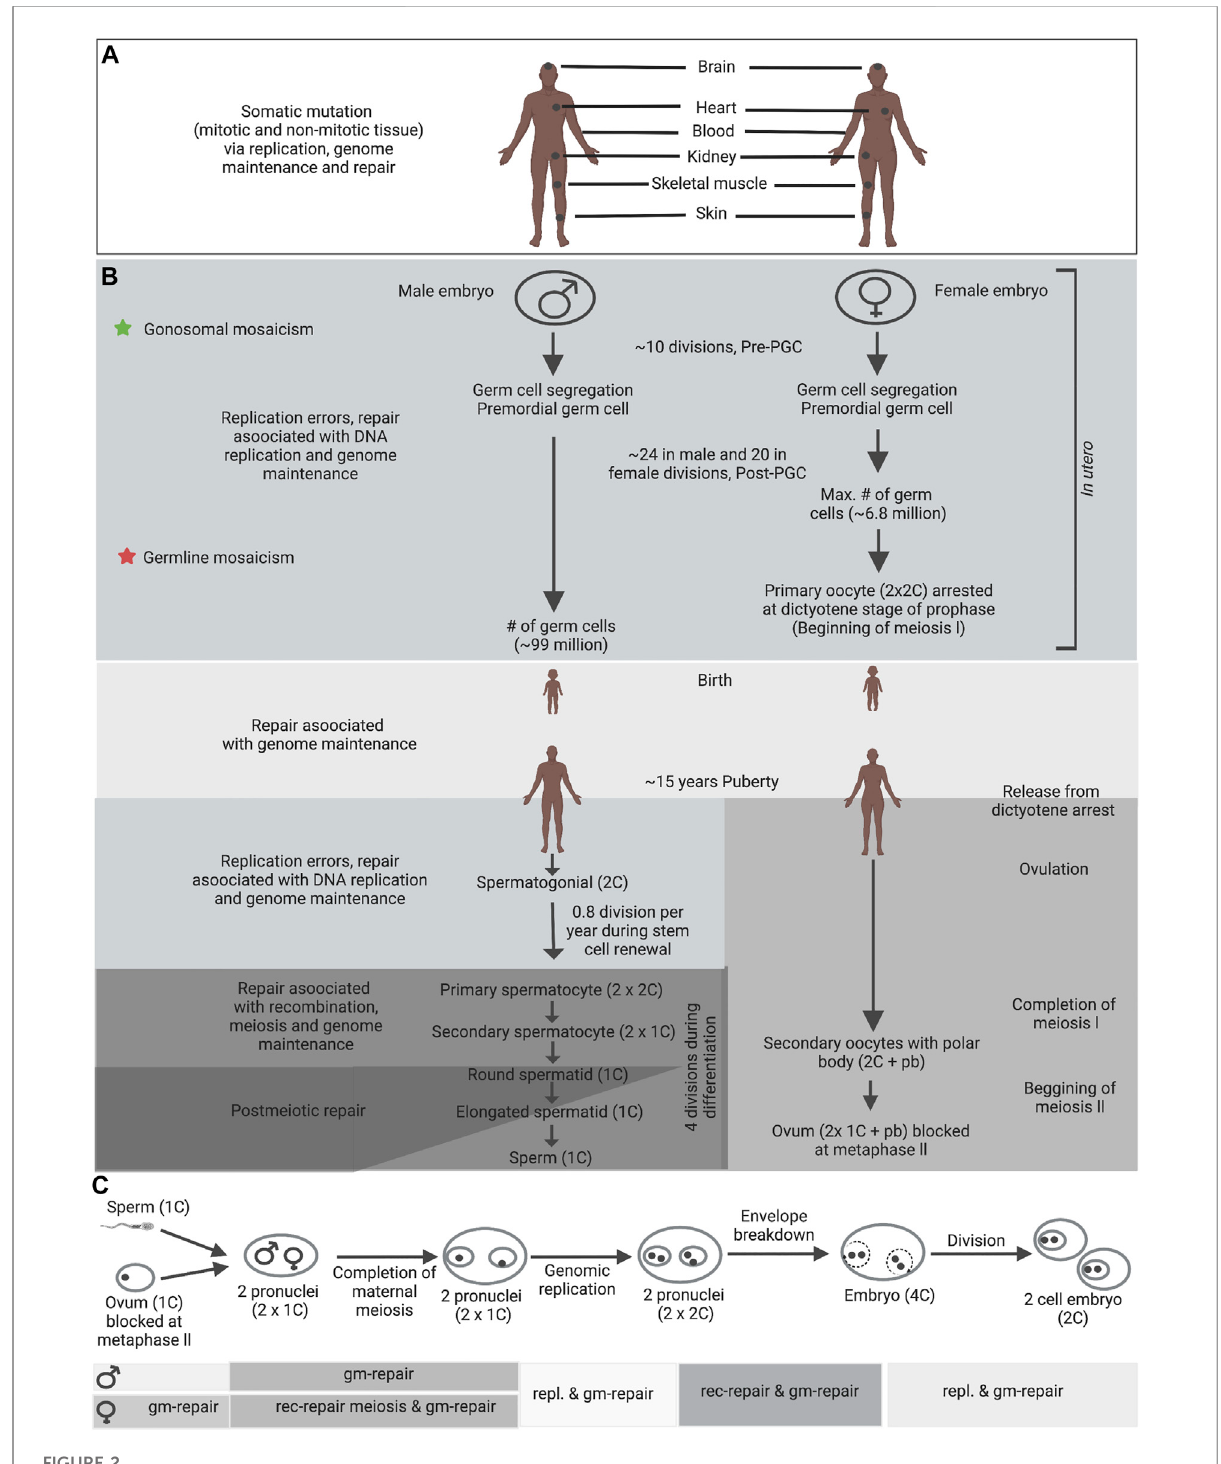
FIGURE 2 Germline and somatic DNA metabolic processes in human. (A) Somatic mosaicism in patients with a genetic disease can exhibit both pre-natal and post-natal tissue speci fi c mosaicism. (B) Depending on the timing of mutations during embryonic development, different types of germline mosaicism can arise; star signs indicate different stages at which mutations can arise and the consequential types of mosaicism. Germline mosaic variants, which were apparent within the parents ’ blood, were possibly established before mesoderm tissue separation from PGCs within the parents (green stars). One potential explanation for mosaic mutations that are only shared by siblings — were not apparent in the parents ’ blood — is that the mutations arose after separation of PGCs from mesoderm in the mosaic parents (red stars). (C) Fertilization and also the steps leading to the